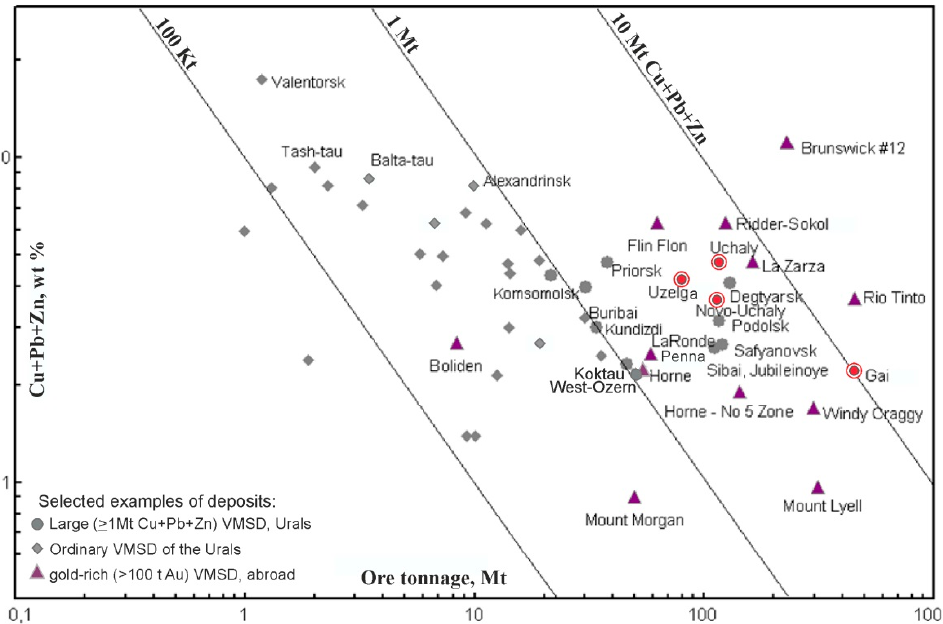
Figure 2. Parameters of VMS deposits of the Urals in terms of ore and base metal tonnage and their comparison with large, Au-rich VMS deposits of the world (>100 t Au); red circles—deposits under consideration. Parameters for other deposits were selected from the review in [84].